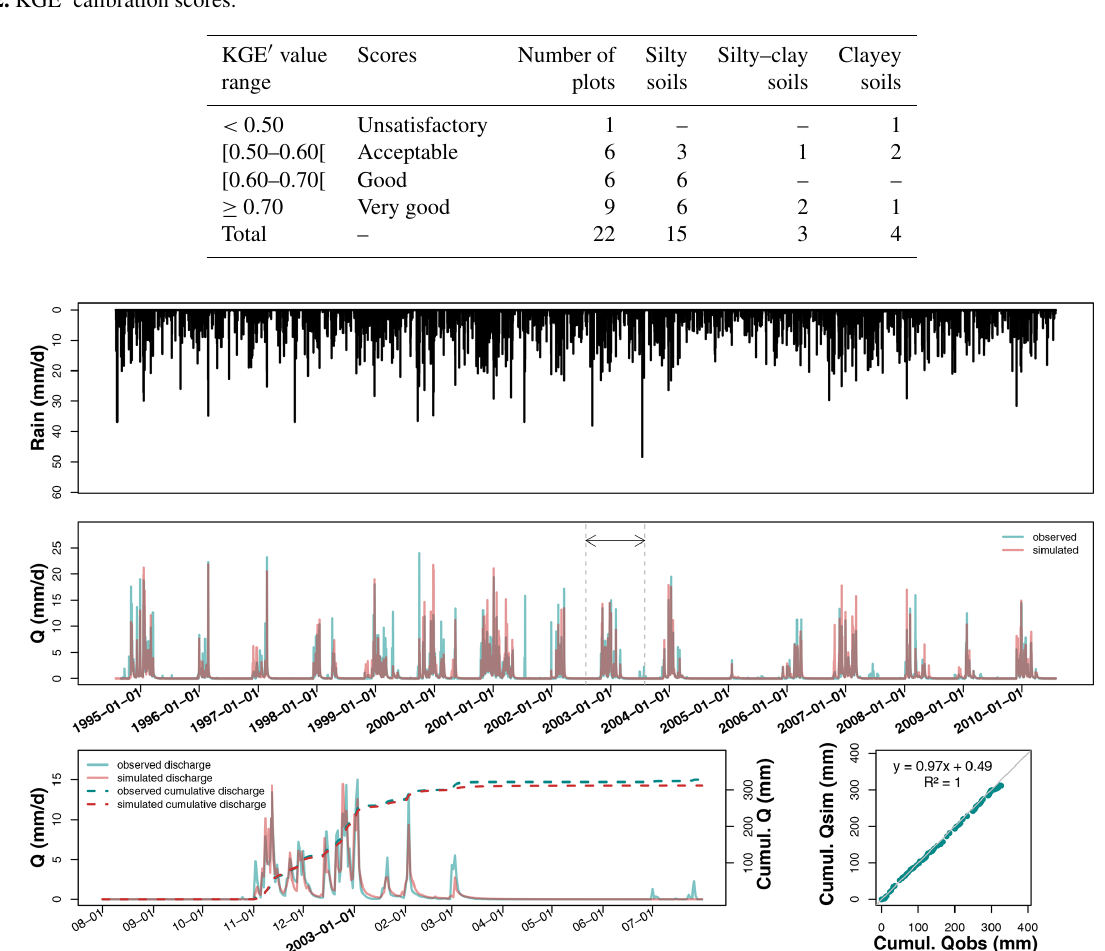
Figure 4. Hydrograph on La_Jaillière_P4 after calibration over the entire available record, plus a magnification of hydrological year 2002– 2003 and the associated temporal and direct comparisons between observed (blue curve) and predicted (red curve) cumulative